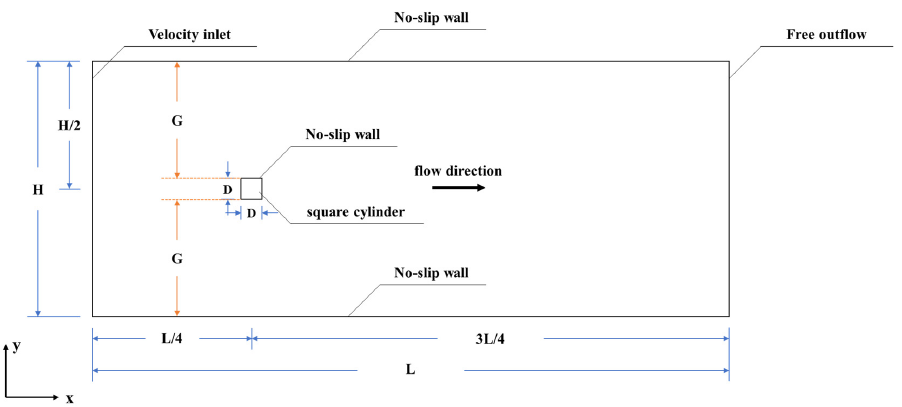
Figure 1. Schematic diagram of the computational domain and boundary conditions.